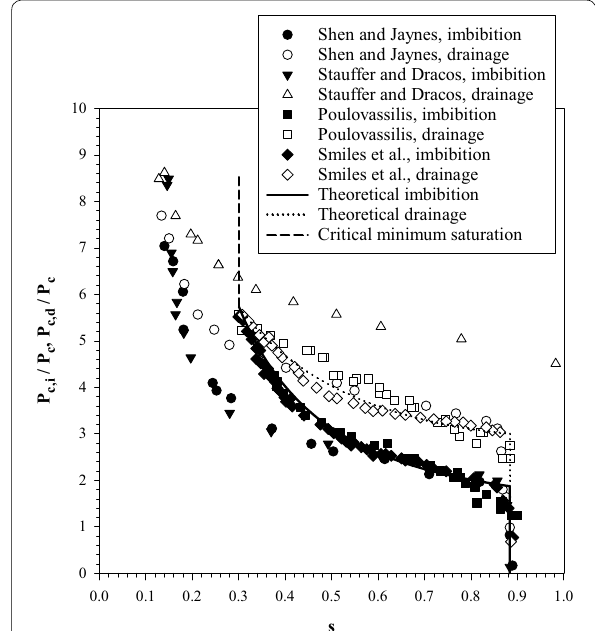
Fig. 1 Variation of imbibition and drainage pressures with relative